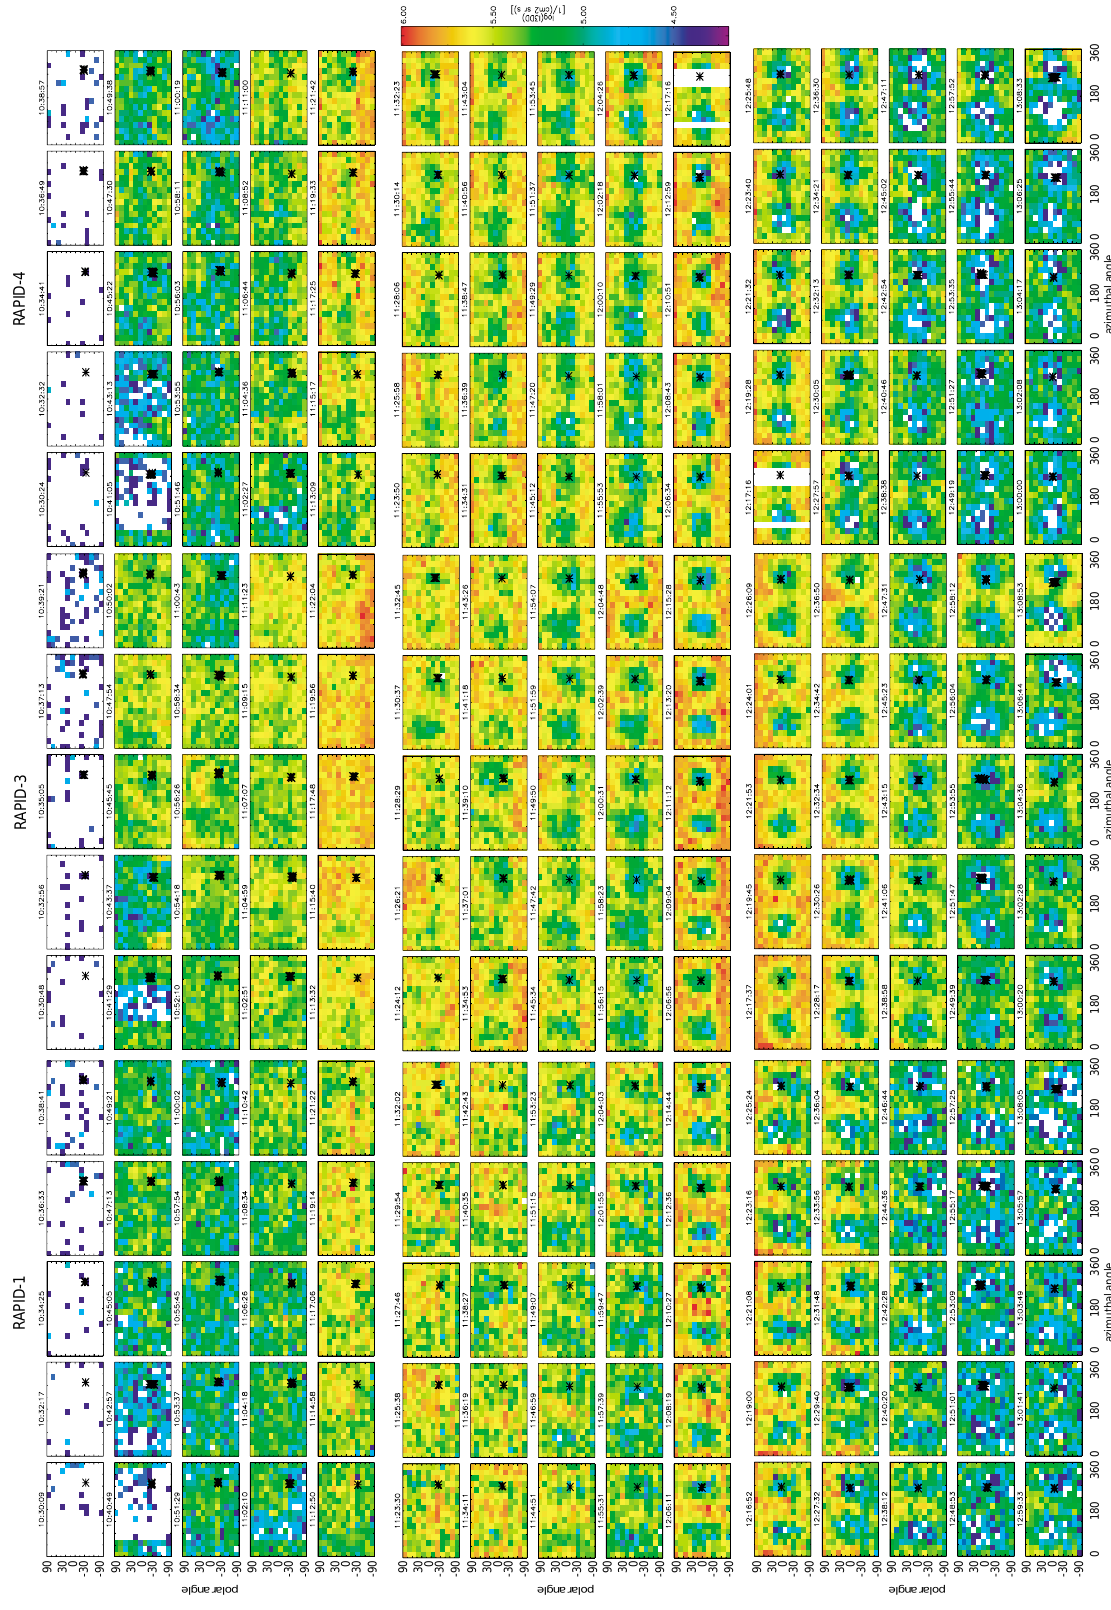
Fig. 6. Polar-azimuthal plots of H flux measured by RAPID on spacecraft 1, 3, 4 on 14 January 2001 between 10:30 and 13:08